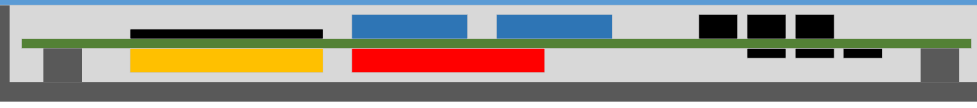
Figure 8. Cooling Moulding fixation for full volume PCM applications. The green PCB in the middle contains double-sided components. The light grey symbolizes the PCM while the blue Glob Top represents the cover of the